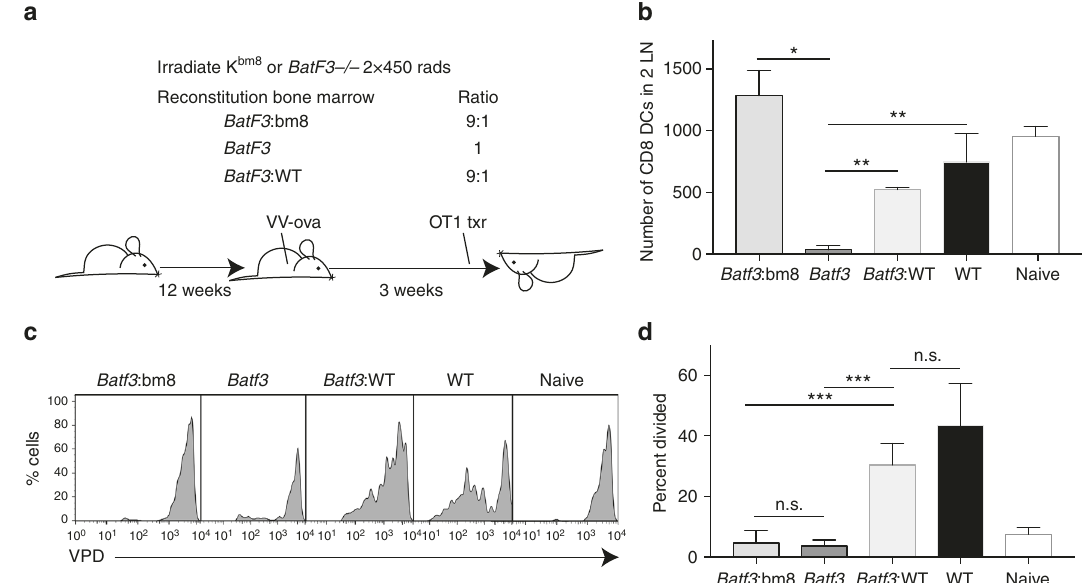
Fig. 6 BatF3 DCs are necessary and suf fi cient for viral-archived antigen presentation. a Schematic of experimental design. Wild-type (WT) or K bm8 mice were lethally irradiated and reconstituted with the indicated mixture of bone marrow. Following reconstitution, mice were infected with vaccinia expressing ovalbumin. Three weeks after immunization, violet proliferation dye (VPD)-labeled OT1 T cells were transferred into mice and T-cell division was assessed 3 days later. b Number of BatF3-dependent DCs was quanti fi ed using CD8 as a marker of BatF3 DCs in each strain used (Supplementary Fig. 3). Statistical analysis between groups was performed using an unpaired t -test, where BatF3: K bm8 compared to BatF3 p -value was 0.0133, BatF3: K bm8 compared to BatF3:WT was 0.0341, Batf3 compared to BatF3:WT was 0.0029, WT compared to BatF3 was 0.0059, and BatF3:WT compared to WT was 0.237. Shown are mean ± standard error of the mean. c Histograms of OT1 divided violet proliferation dye-labeled T cells from individual mice used in the chimera experiment. d Percent divided was calculated for all groups and statistical analysis between groups was performed using an unpaired t -test, where BatF3 : K bm8 compared to BatF3 p -value was 0.6125, BatF3 : K bm8 compared to BatF3:WT was < 0.0001, Batf3 compared to BatF3 :WT was < 0.0001, and BatF3 :WT compared to WT was 0.071. Shown are mean ± standard error of the mean. Six mice per group were evaluated from two separate lethally irradiated